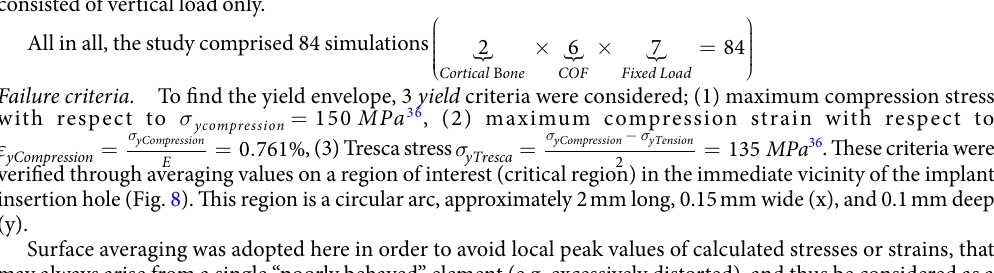
Failure criteria. To find the yield envelope, 3 yield criteria were considered; (1) maximum compression stress